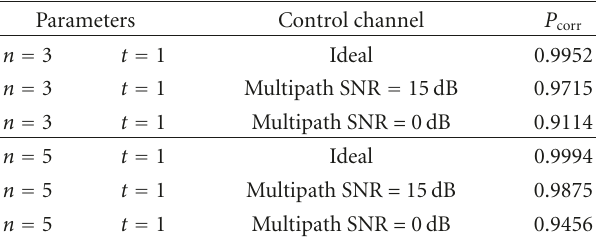
Table 6: E ff ects of channel impairments on the exchanged infor-